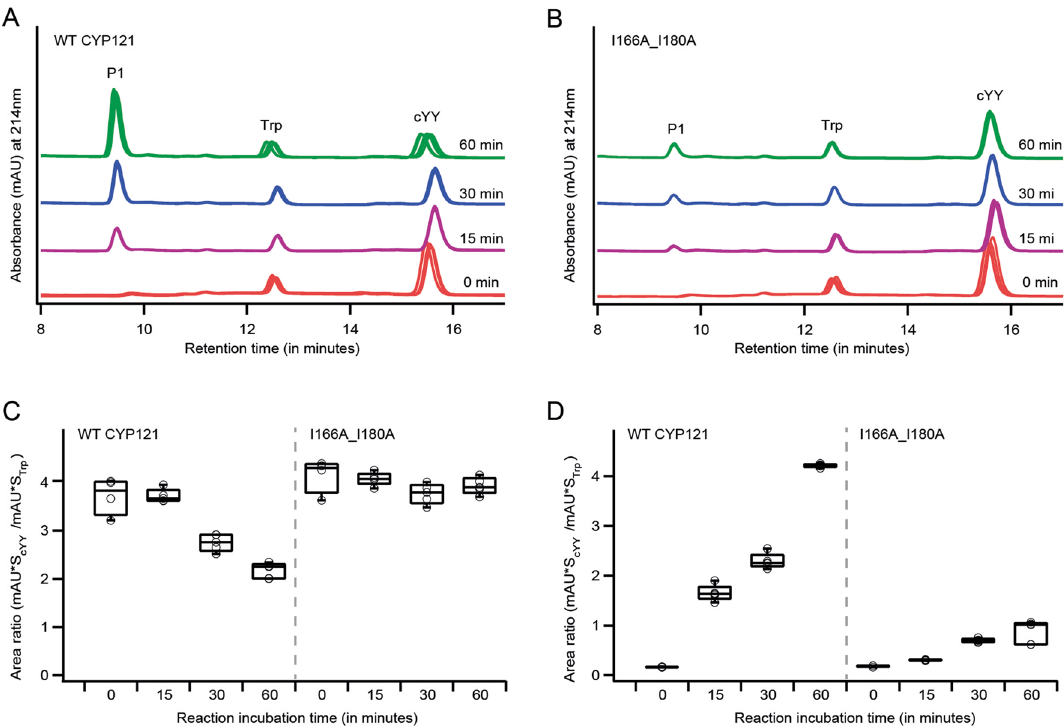
Figure 2. Time-course reconstituted CYP121A1 functional assays. A reconstituted functional assay using cYY as the substrate quenched at 0, 15, 30, and 60 min and resolved by using HPLC. ( A ) HPLC traces of replicates at different time points for ( A ) wild type CYP121A1 and ( B ) mutant I166A_I180A with increment in product formation (P1) and depletion in the substrate (cYY). Relative substrate depletion ( C ) and product formation ( D ) were measured using tryptophan as an internal standard. HPLC traces in ( A ) and Plots in ( B ) were generated using Igor Pro Version 6.37 (https ://www.wavem etric s.com/) and graphics designed by Adobe Illustrator CS5 (https ://www.adobe